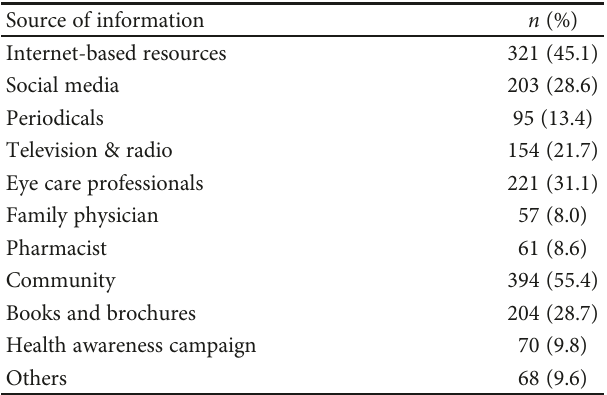
Table 4: Sources of information for accessing knowledge regarding eye diseases and eye care among Saudi adults in Riyadh city 2016.